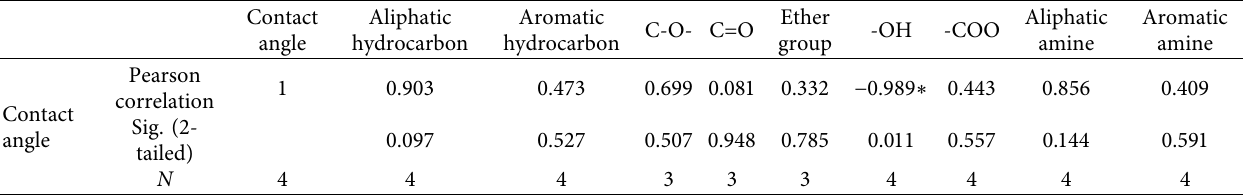
Table 7: Linear correlation analysis of wettability and surfactant functional group